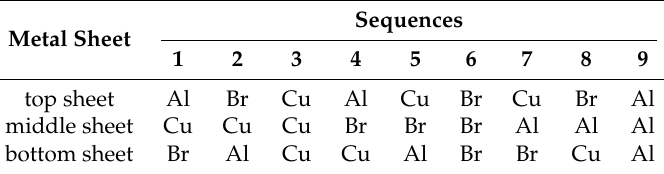
Table 2. The stacked of metal sheets with a series